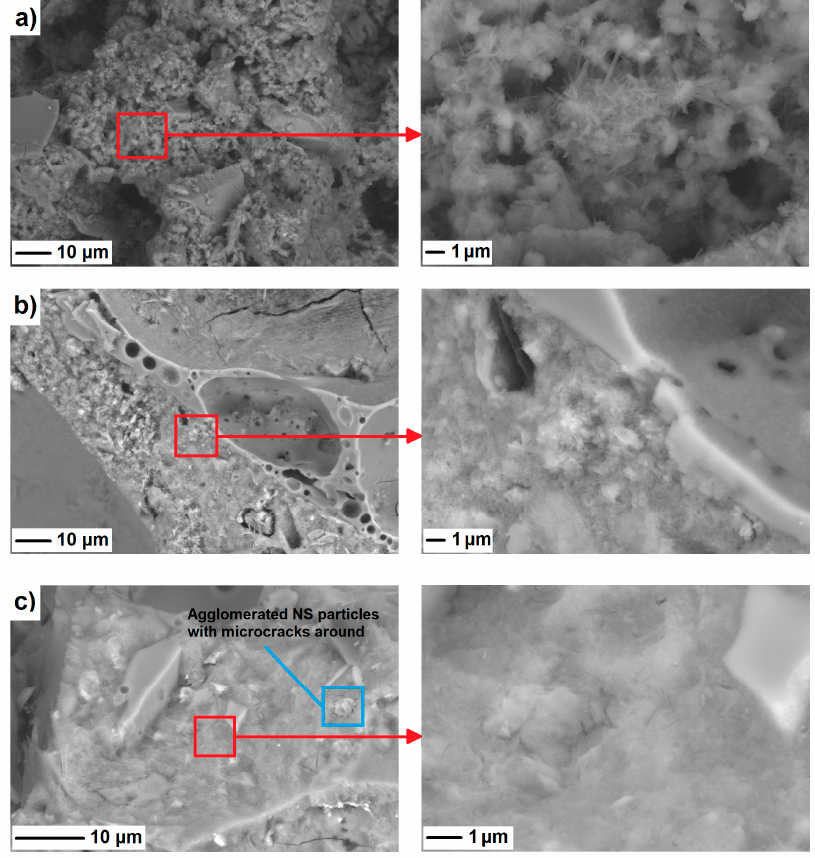
Figure 11. Scanning electron microscope micrographs of R ( a ), NS2 ( b ), and NS4 ( c ) after 28 days of curing.